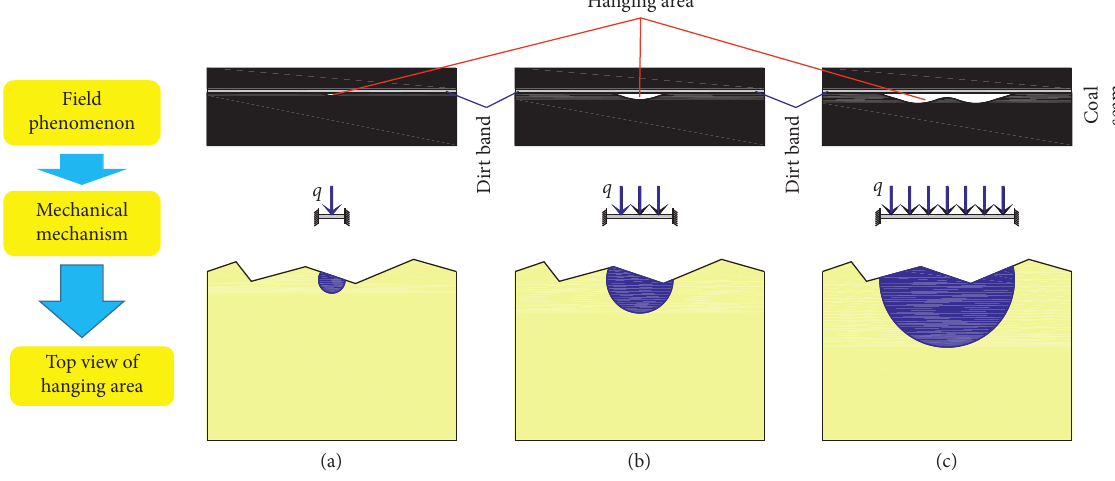
Figure 3: Hanging area under different conditions: (a) SOSCT; (b) MOCT with three SOs; (c) MOCT with six